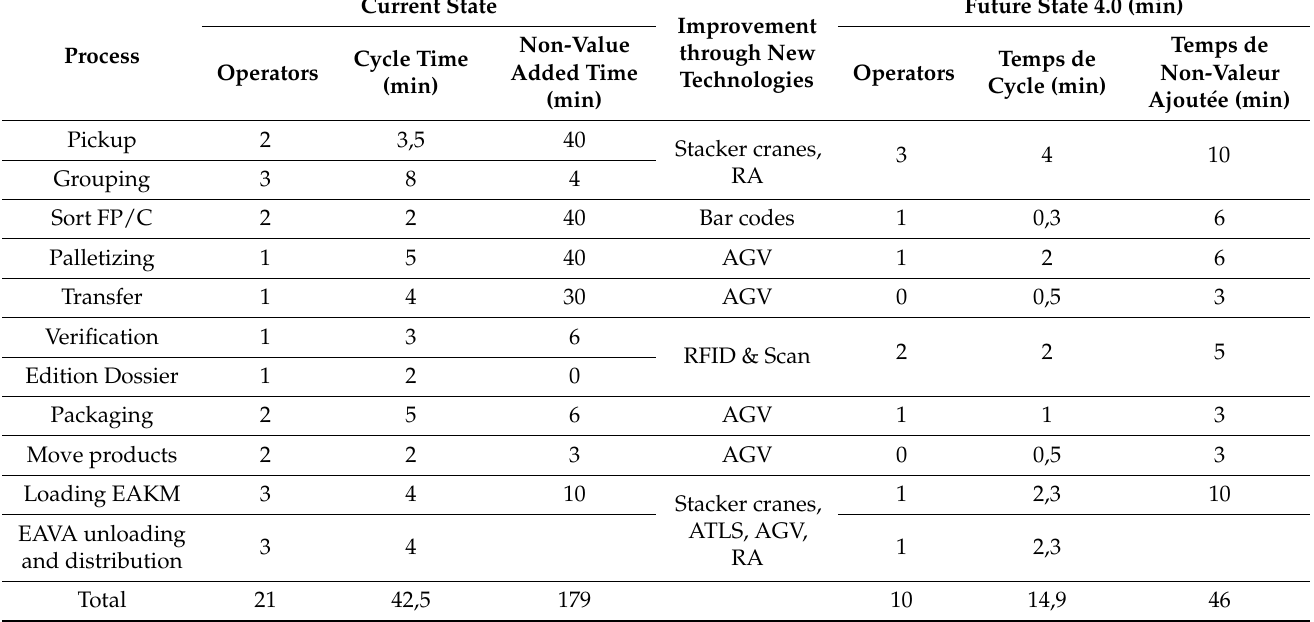
Table 6. Comparison table between current state and future state 4.0 in warehouses.